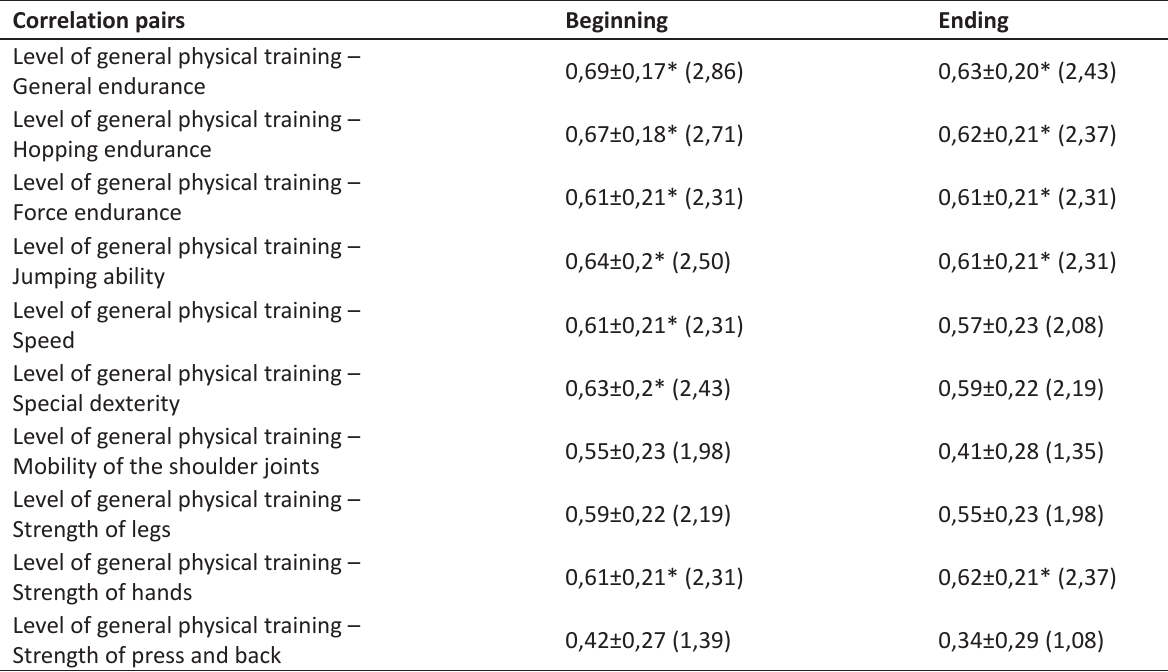
Table 3. Coefficients of correlation between the level of general physical fitness and indicators of special physical fitness in volleyball players at the beginning of the first stage of the experiment ( х ±S) Correlation